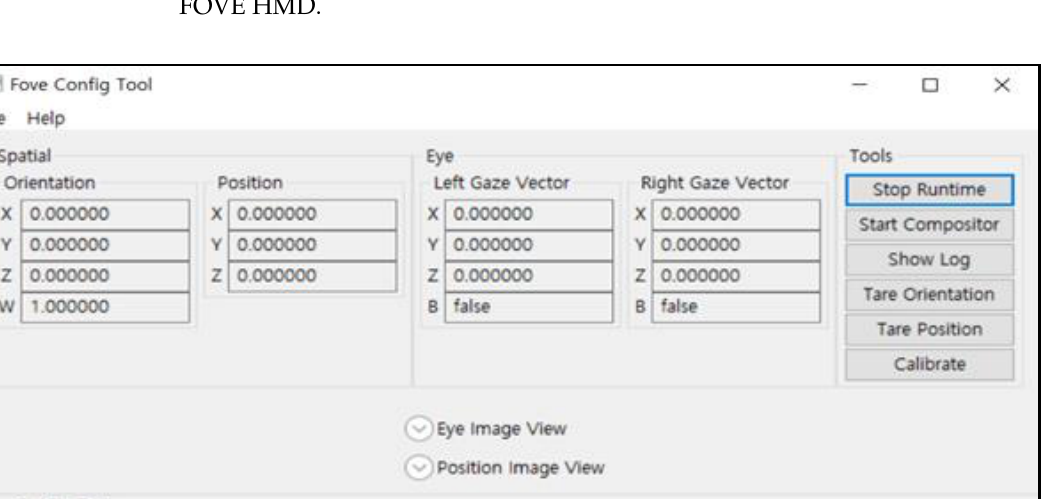
Figure 4. FOVE configuration total displaying device and target transform of eye tracking.